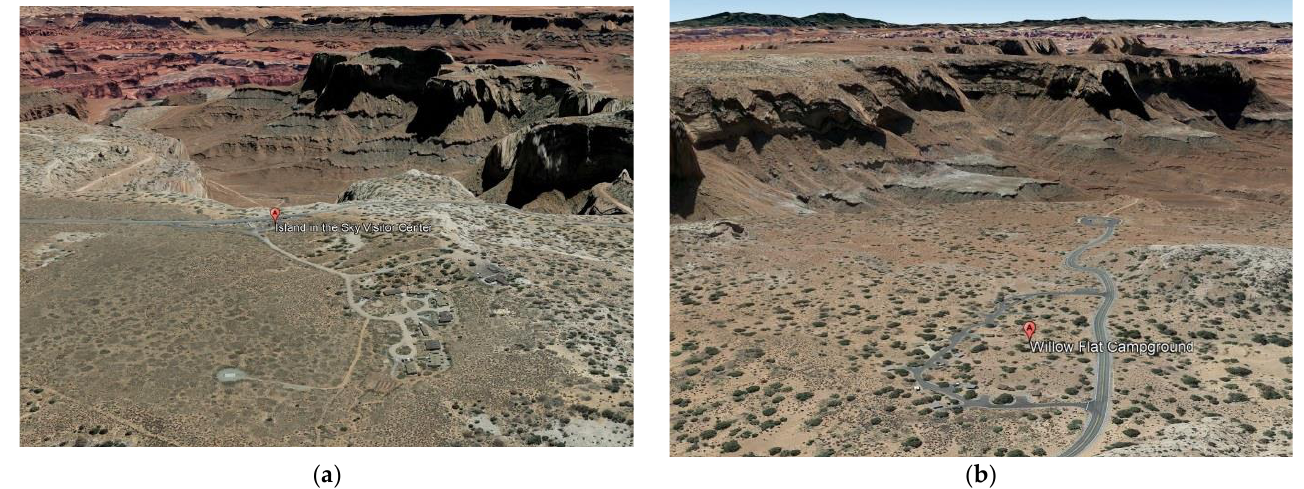
Figure 13. ( a ) The Island in the Sky visitor centre (from Google Earth Pro V 7.3.4 (25 August 2019), 38°27′35.40″N, 109°49′15.16″W, Eye alt 1.78 km, Landsat, Copernicus, Maxar Technolo-